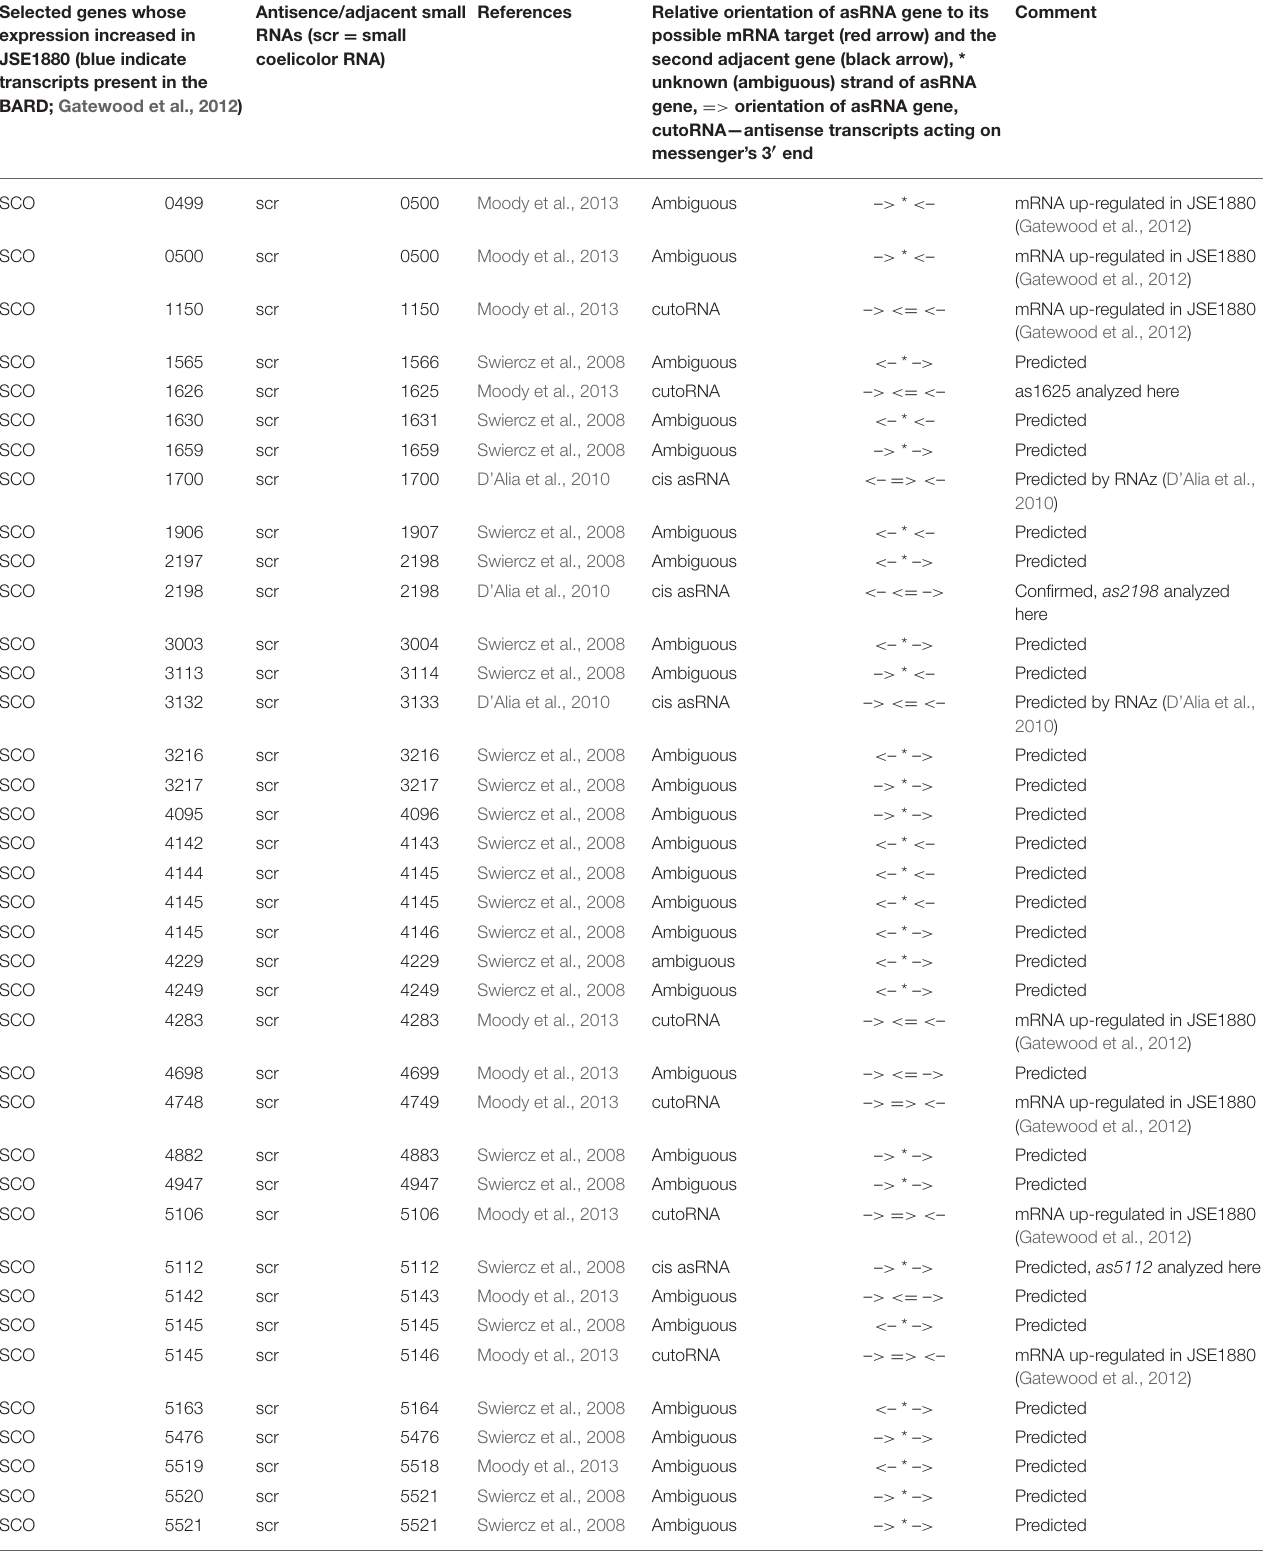
TABLE 1 | In silico search for sRNA genes adjacent to mRNAs that are up-regulated in rnc mutant. Selected genes whose expression increased in JSE1880 (blue indicate transcripts present in the BARD; Gatewood et al.,